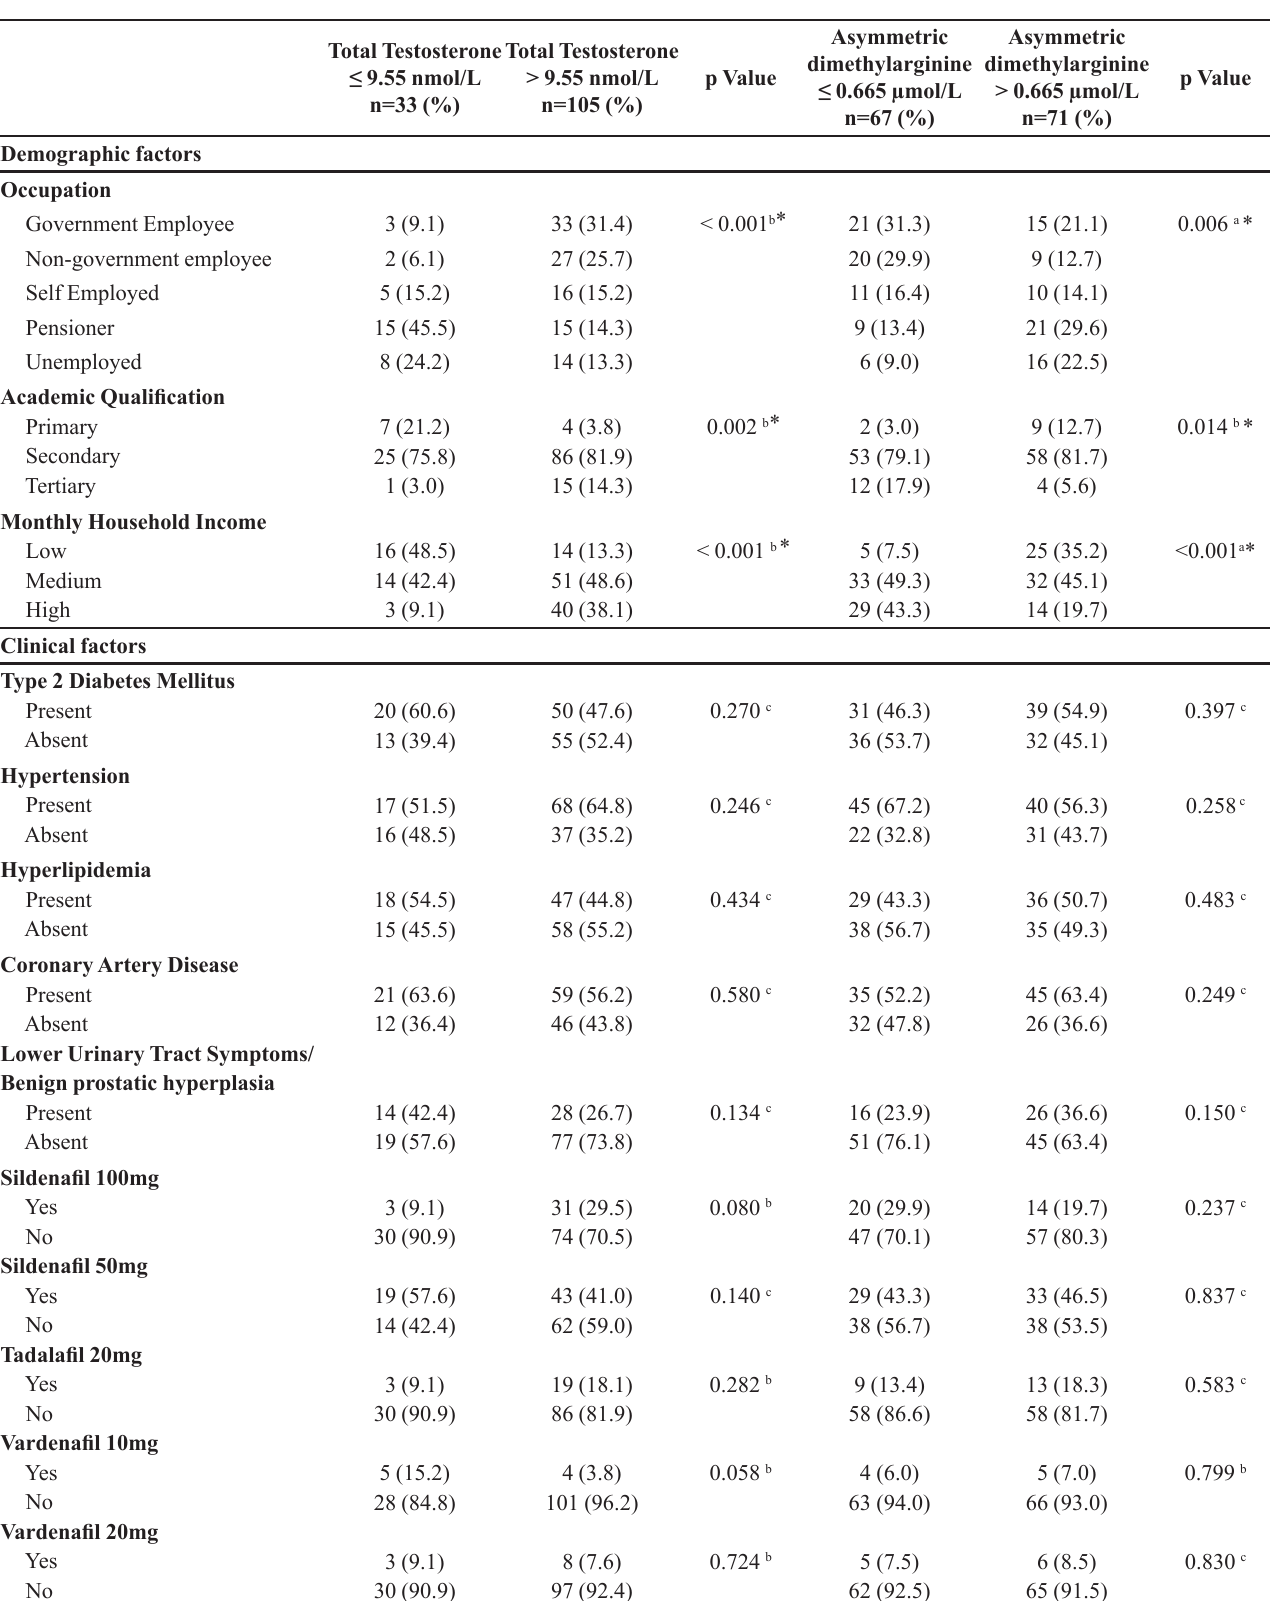
TABLE II - Association of Demographic, Clinical, and Lifestyle factors with Biomarkers level (TT and ADMA), n= 138